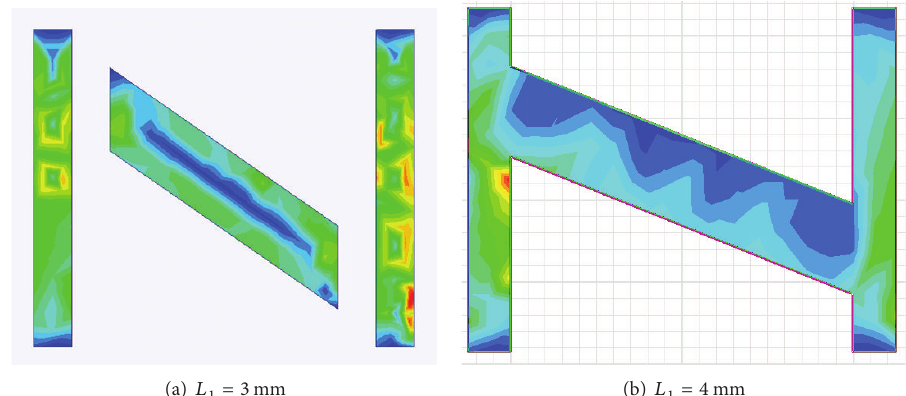
Figure 6: Magnitude distribution of 𝐸 𝑦 in the N-shaped slot.